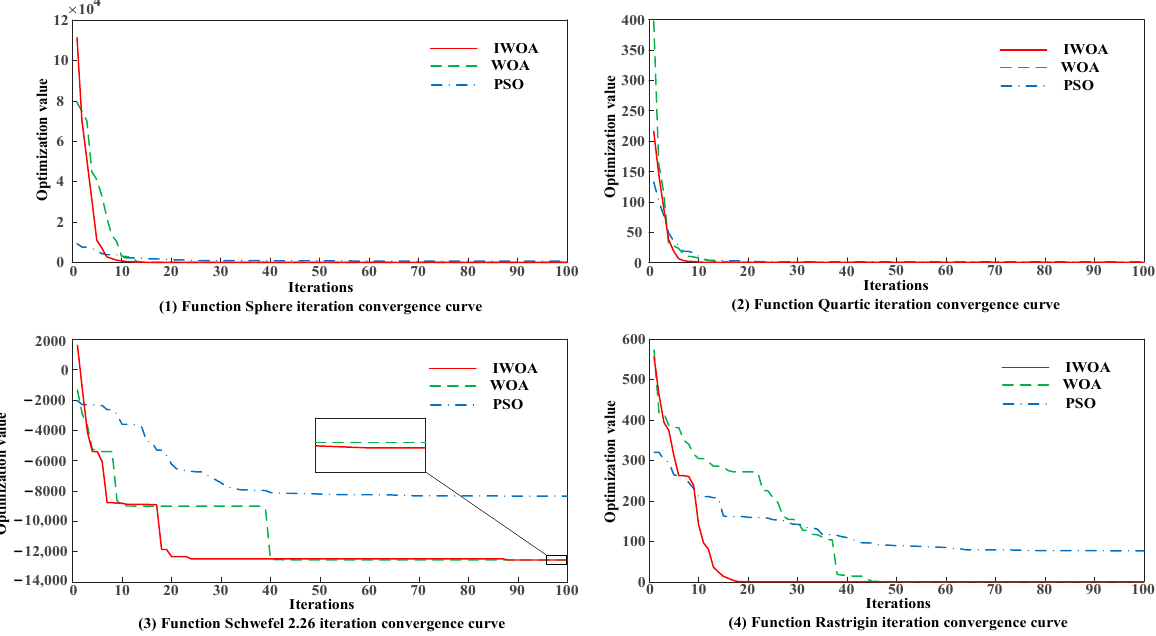
(3) Function Schwefel 2.26 iteration convergence curve Figure 4. Convergence curves of test functions.